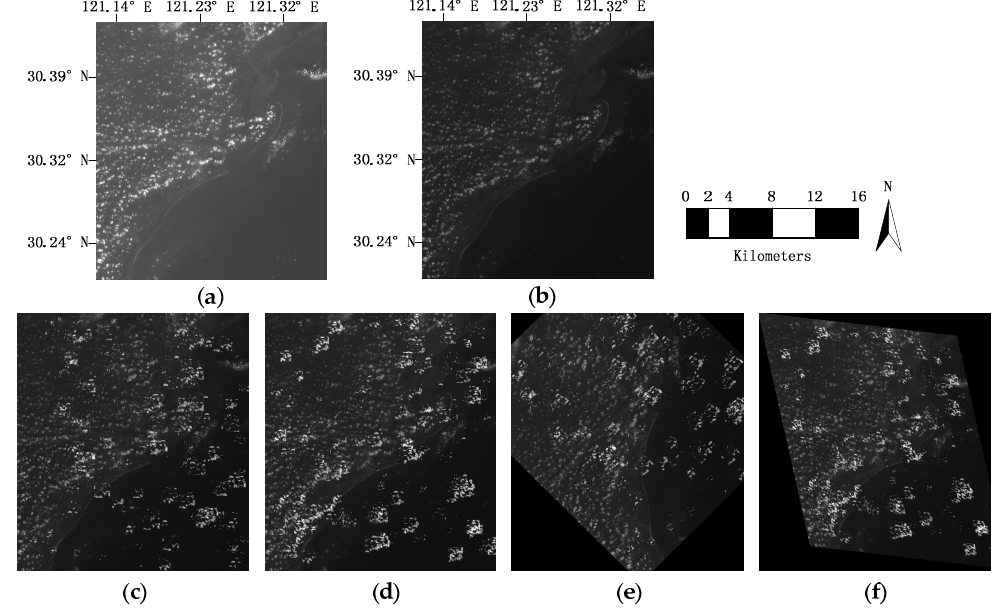
Figure 9. Examples of the simulated images. ( a ) A satellite image from Landsat5, Band1; ( b ) the corresponding image of ( a ) from Landsat5, Band2; ( c ) asimulated image by adding sixty randomly-distributed patches of cloud to ( b ); ( d ) asimulated image by adding eighty randomly-distributed patches of cloud to ( b ); ( e ) asimulated image by adding a certain amount of affine transformations to ( c ); ( f ) asimulated image by adding a certain amount of affine transformations to ( d ). Table 2. The complete information of all experimental satellite image pairs.